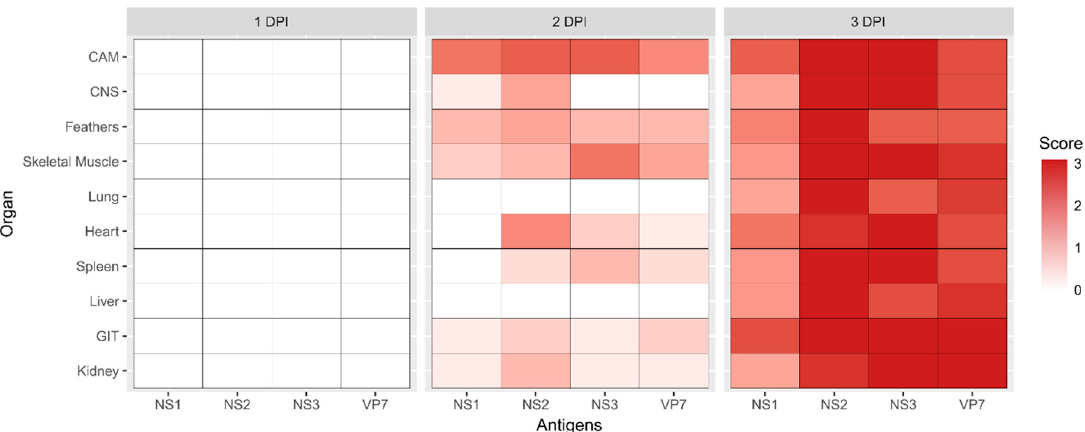
Figure 4. The abundance of viral antigens and their distribution, plotted as heat maps, in various organs of the chicken embryo at days 1, 2, and 3 post infection. Viral antigen loads were assessed semi-quantitatively at 40 × magnification. Scores: 3 = abundant, 2 = moderate, 1 = minimal, 0 = undetectable. CAM = chorioallantoic membrane; CNS = central nervous system; GIT = gastrointestinal tract.